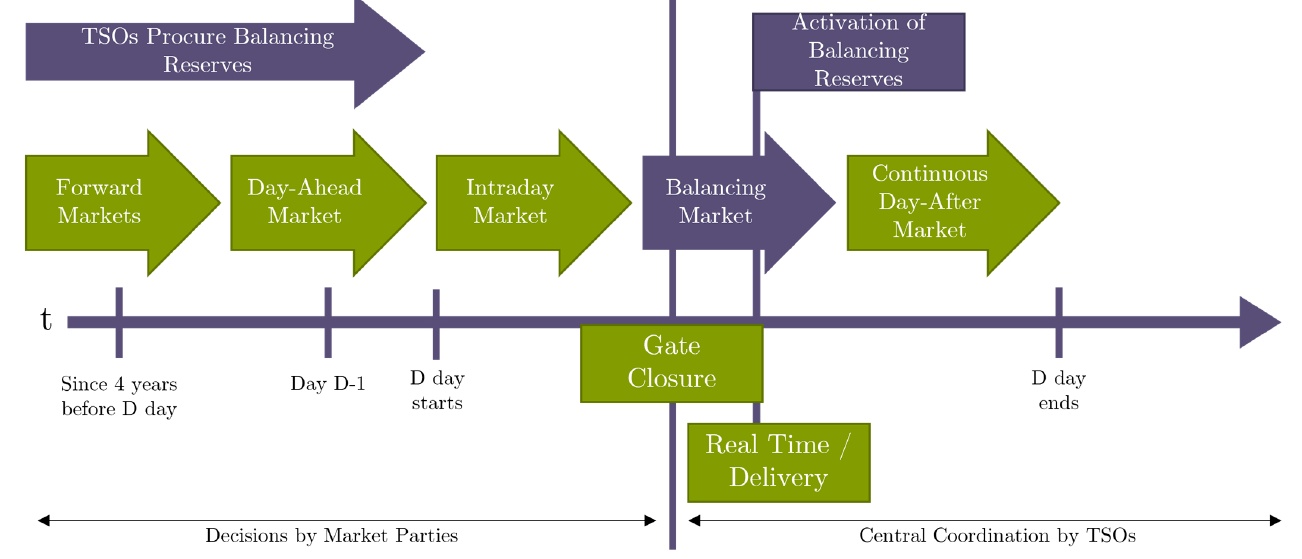
Figure 2. Time sequence of electricity markets.